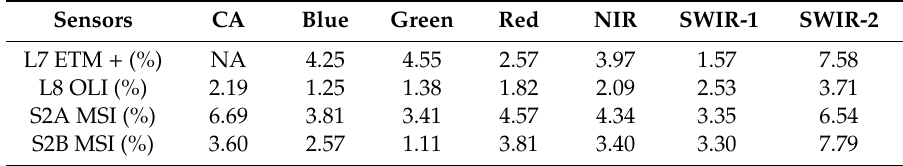
Table 13. Accuracy between measured and Niger 2 simulated values. Sensors CA Blue